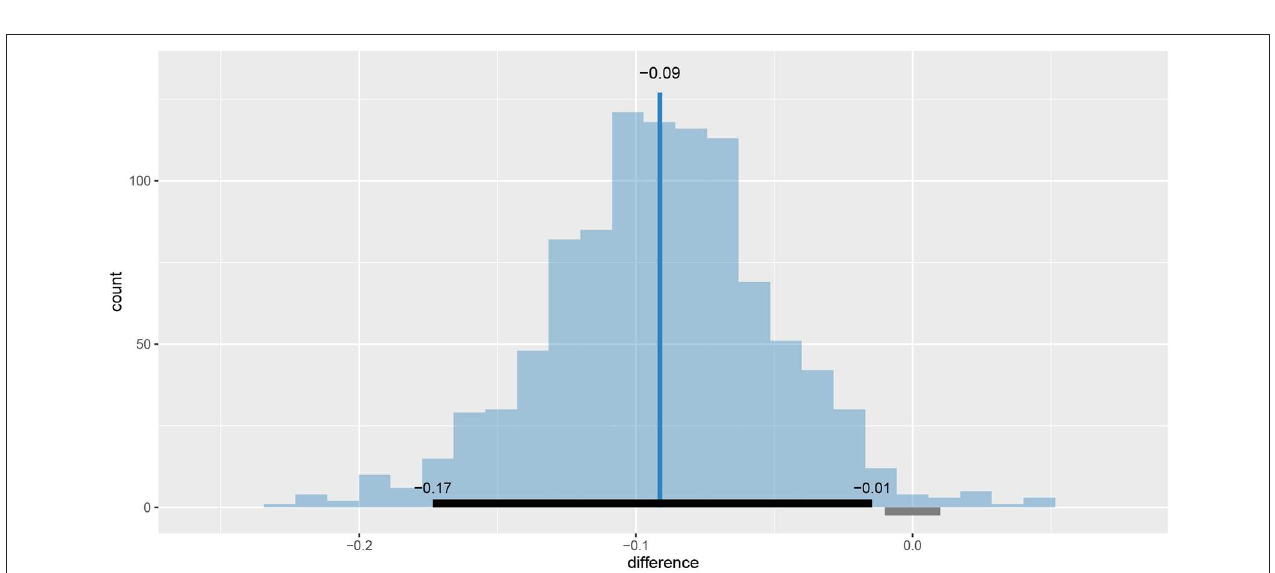
FIGURE 8 | The visualization of the difference in mean reaction times between rt_control_fit and rt_test_fit . The histogram visualizes the distribution of the difference, vertical blue line denotes the mean, the black band at the bottom marks the 95% HDI interval and the gray band marks the ROPE interval. Since the entire 95% HDI of difference is negative and lies outside of the ROPE interval, we can confidently conclude that healthy subjects are faster on average.